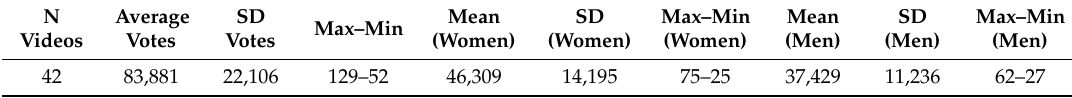
Table 4. Data from the sample of participants by selected videos in the UC3M4Safety